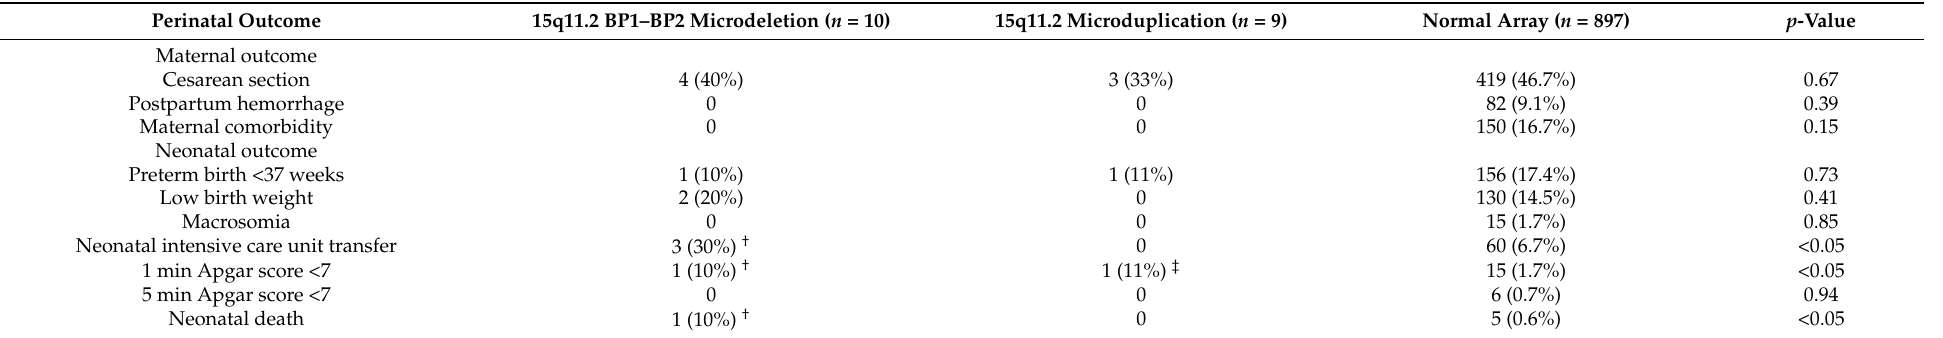
Table 5. Perinatal outcomes between the 15q11.2 CNV groups and the normal array